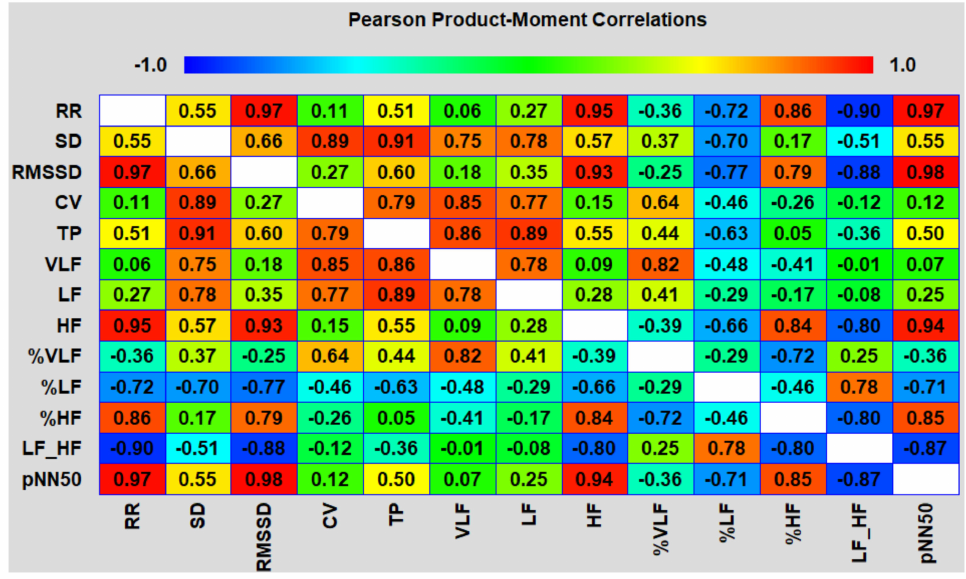
Figure 15. Correlation matrix of HRV indicators at the final stage of the test from the point of intersection of the two green straight trend lines in Figure 14 to the end of using the last